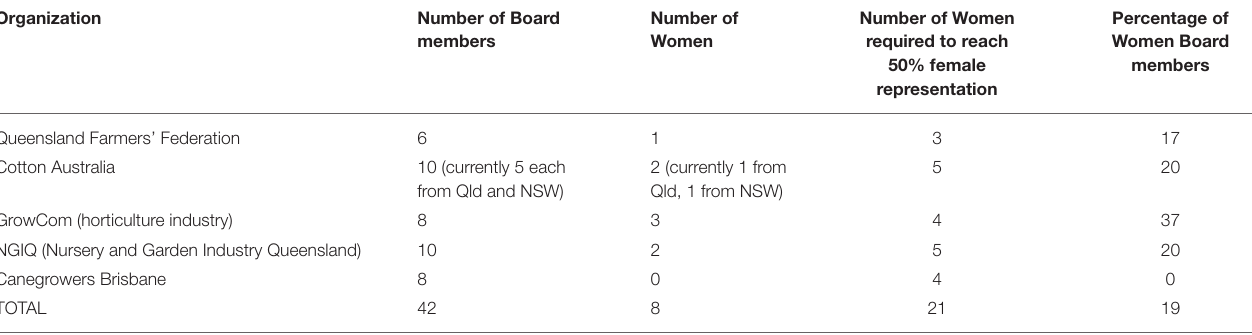
TABLE 1 | Female representation on five of Queensland’s agricultural boards: Queensland Farmers’ Federation, Cotton Australia, NGIQ, GrowCom, and Canegrowers Brisbane.